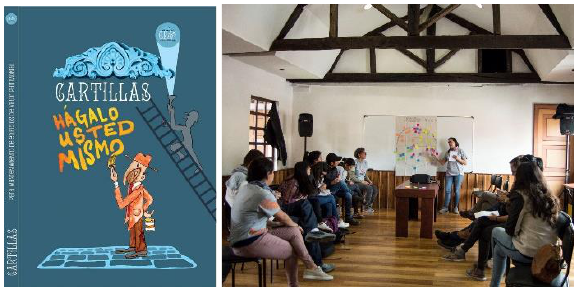
Figures 6 and 7. Left: Maintenance Primer. Right: El Vergel Campaign monitoring group, evaluation